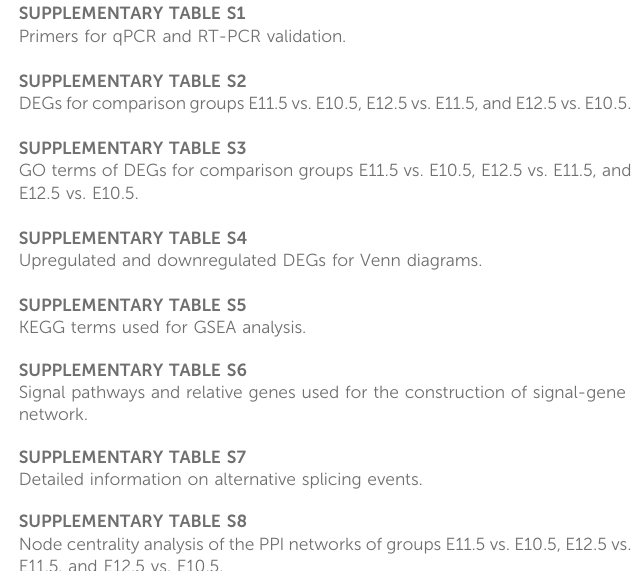
SUPPLEMENTARY TABLE S1 Primers for qPCR and RT-PCR validation.